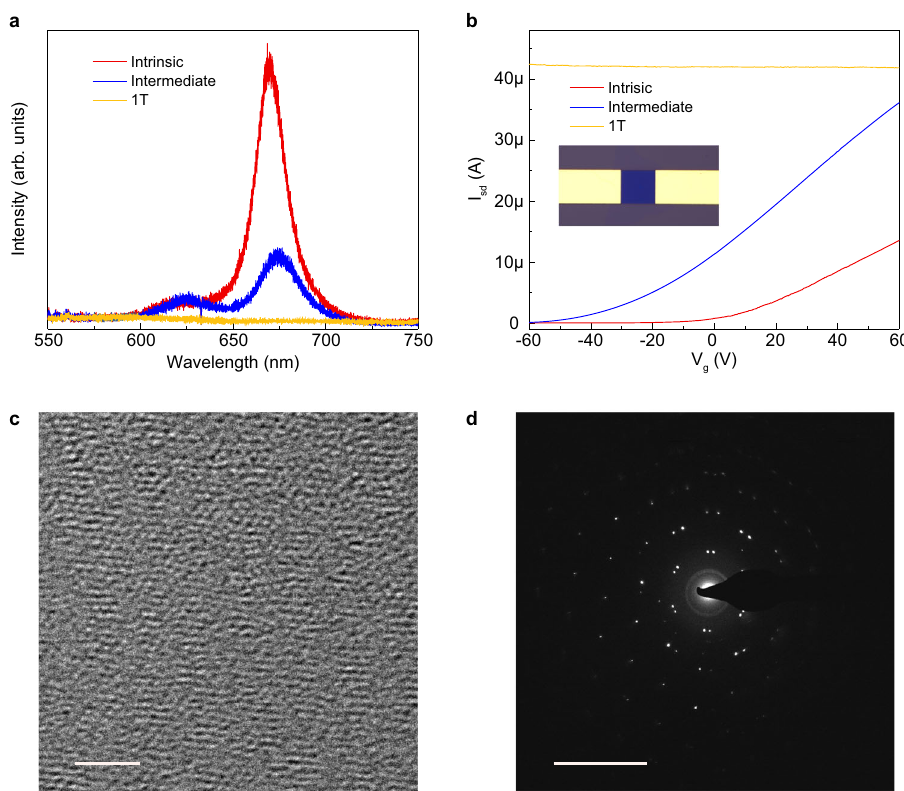
Fig. 4 Characterizations of the intermediate state. a Photoluminescence of a twisted bilayer MoS 2 sample before intercalation, in the intermediate state, and after transformation to the 1 T phase. b Room-temperature transfer characteristics for a twisted bilayer MoS 2 FET before intercalation, in the intermediate state, and after transformed to 1 T phase with 1 V applied bias voltage (the width of the contact is 10 μ m). c High resolution cryo-TEM image (scale bar: 2 nm) of a twisted bilayer MoS 2 after 15 min lithium intercalation and d the corresponding electron diffraction pattern (scale bar: 10 nm − 1